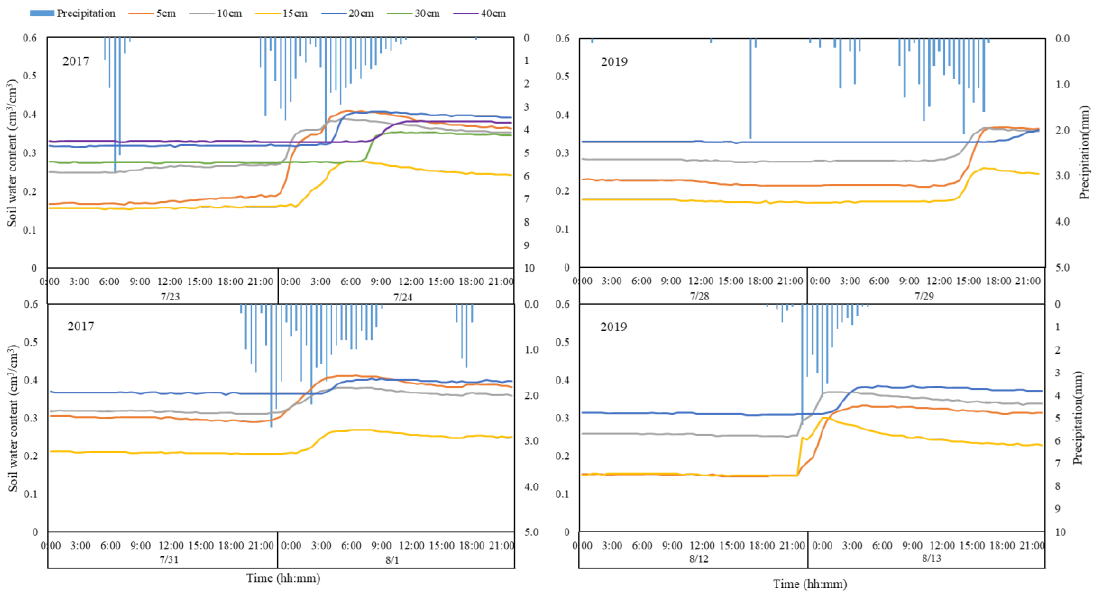
Figure 8. Soil water content response process to rainfall.